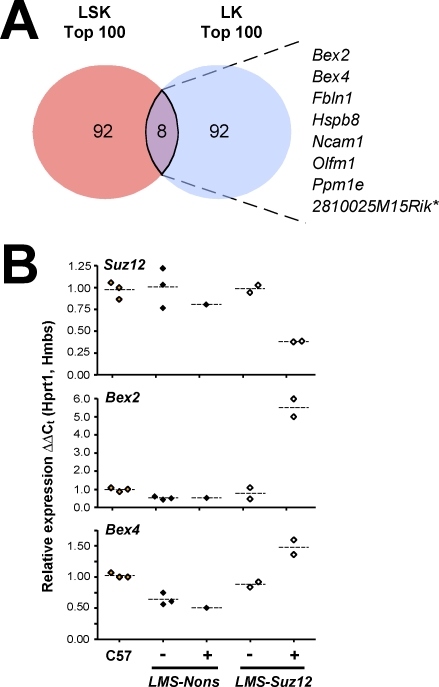
An Analysis of Gene Expression Changes in PRC2 Deficient Hematopoietic Progenitors Cells(A) A direct comparison identified eight genes that were significantly up-regulated in both Suz12Plt8/+ LSK cells (LSK top 100) and in LK cells that expressed the Suz12 shRNA (LK top 100). This included Brain expressed 2 (Bex2), Bex4, Fibulin 1 (Fbln1), Heat shock protein 8 (Hspb8), Neural cell adhesion molecule 1 (Ncam1), Olfactomedin 1 (Olfm1), and Protein phosphatase 1E (Ppm1e).(B) Expression changes were confirmed in sorted LK samples using Q-PCR. Samples were sorted based upon expression of GFP (+/–), and expression values were compared to LK cells isolated from wildtype C57BL/6 mice (C57).